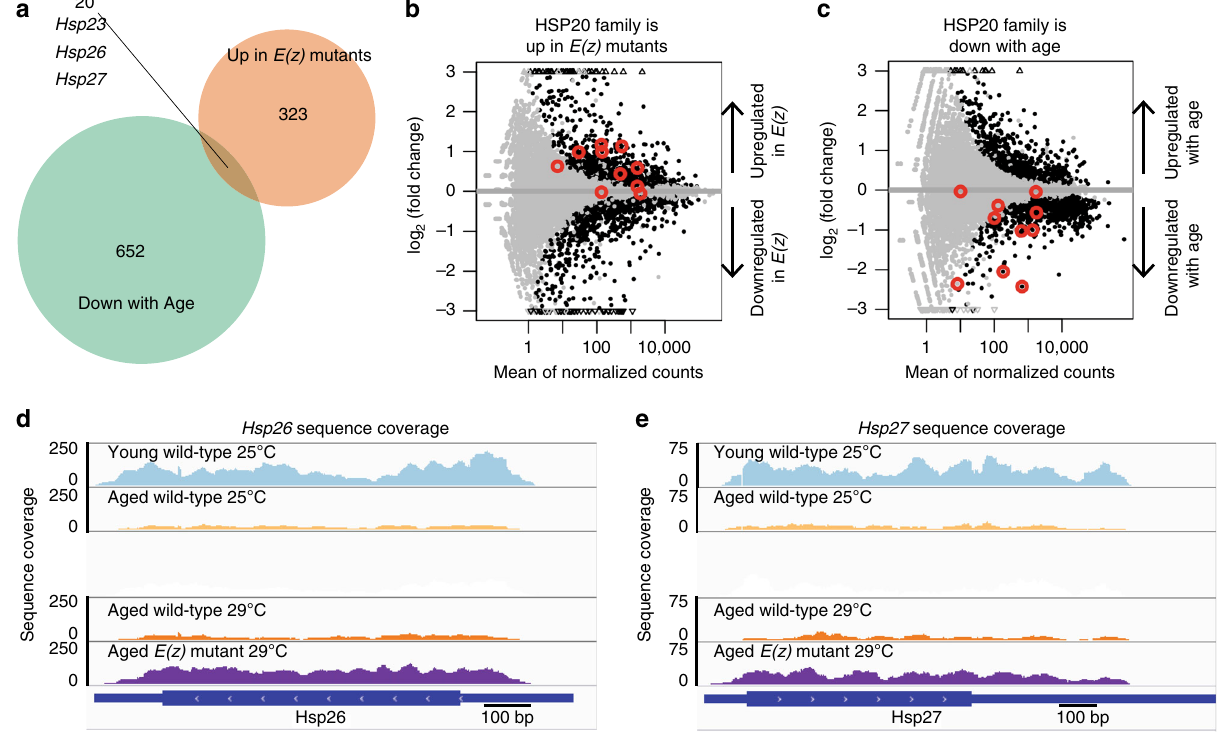
Fig. 7 The small HSP chaperone family is regulated with age and by E(z) . RNA-seq was performed on 20d brain tissue from animals transheterozygous for the E(z) 61 and E(z) 731 alleles, and on wild-type. Because the E(z) 61 allele is temperature-sensitive, two temperatures were used, 25 °C (permissive) and 29 ° C (restrictive). Wild-type brains, 3d (young) and 20d (aged) 25 °C, were also dissected and RNA-seq performed. Genes were selected as differentially expressed using a Benjamini-Hochberg p < 0.05 and at least a 0.5 absolute log 2 fold-change. a Gene overlap. Twenty genes had an expression pattern consistent with being a target of E(z) with age in the brain: upregulated in E(z) and downregulated with age. b , c Differential gene expression analysis of sHSP family genes. Gray data points are genes not differentially expressed. Black data points are genes with signi fi cant changes in expression ( p <0.05, DEseq2 negative binomial generalized linear model, Benjamini-Hochberg correction). Red circles mark the sHSP family members Hsp23, Hsp26, Hsp27, Hsp67Ba, Hsp67Bc, l(2)e fl , CG4461, CG7409, CG13133 , and CG14207 . Hsp22 was not included because no reads mapped uniquely to this gene. b Small HSP genes are upregulated in 20d E(z) mutant brains. Among these, Hsp23, Hsp26, Hsp27 , and CG7409 were signi fi cantly elevated in E(z) mutants ( p < 0.05, DESeq2 negative binomial generalized linear model, Bonferroni correction), compared to 20d wild-type. c Small HSPs are downregulated in the brain with age. Hsp23, Hsp26, Hsp27, Hsp67Ba , and Hsp67Bc were signi fi cantly decreased ( p < 0.05, DESeq2 negative binomial generalized linear model, Bonferroni correction) with age comparing 20d to 3d wild-type. d , e Sequence coverage at speci fi c loci indicates silencing of sHSPs with age, and release from silencing in E(z) mutants. Read coverage at the individual sHSP loci ( d ) Hsp26 and ( e ) Hsp27 demonstrates a decrease in expression of sHSPs with age. Young wild-type animals express high levels (blue) while aged wild-type animals have less sHSP expression (yellow). E(z) mutation (purple) results in increased sHSP levels compared to age and temperature matched controls (orange). Y-axis indicates sequence read coverage from one biological replicate from each cohort. Each library shown had similar depth of sequencing (24 – 26 × 10 6 reads). X-axis indicates position along the gene. Expression levels in